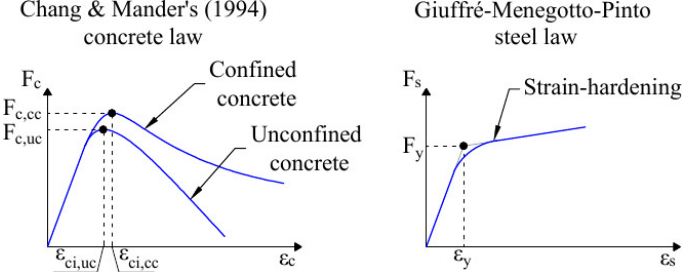
Figure 4. Generic representation of concrete and steel material